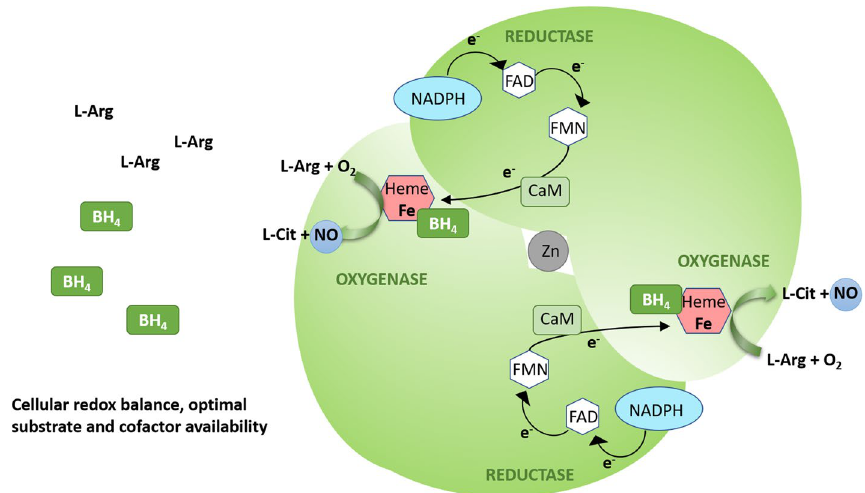
Fig. 1 Schematic eNOS homodimer structure with two monomers orientated "head‑to‑tail". Each monomer consists of a C‑terminal reductase domain that binds NADPH, FAD, and FMN, a central calmodulin‑binding region, and an N‑terminal oxygenase domain that binds substrate L‑Arg, oxygen, heme, and BH 4 . The formation of a homodimer enables the transfer of electrons from the reductase domain of one monomer to the oxygenase domain of the second monomer. The dimeric structure is stabilized by heme binding and by zinc ion in the zinc‑thiolate cluster at the dimer interface. During catalysis, electrons from NADPH flow through the flavins FAD and FMN to the heme of the opposite monomer and CaM increases the rate of interdomain electron transfer. Heme reduction enables O 2 binding, and BH 4 can donate an electron to reduce and activate O 2 . When cellular redox balance is maintained, and the substrate L‑Arg and the essential cofactor BH 4 availabilities are optimal, O 2 reduction is coupled to L‑Arg oxidation and NO synthesis. L‑Cit is formed as a